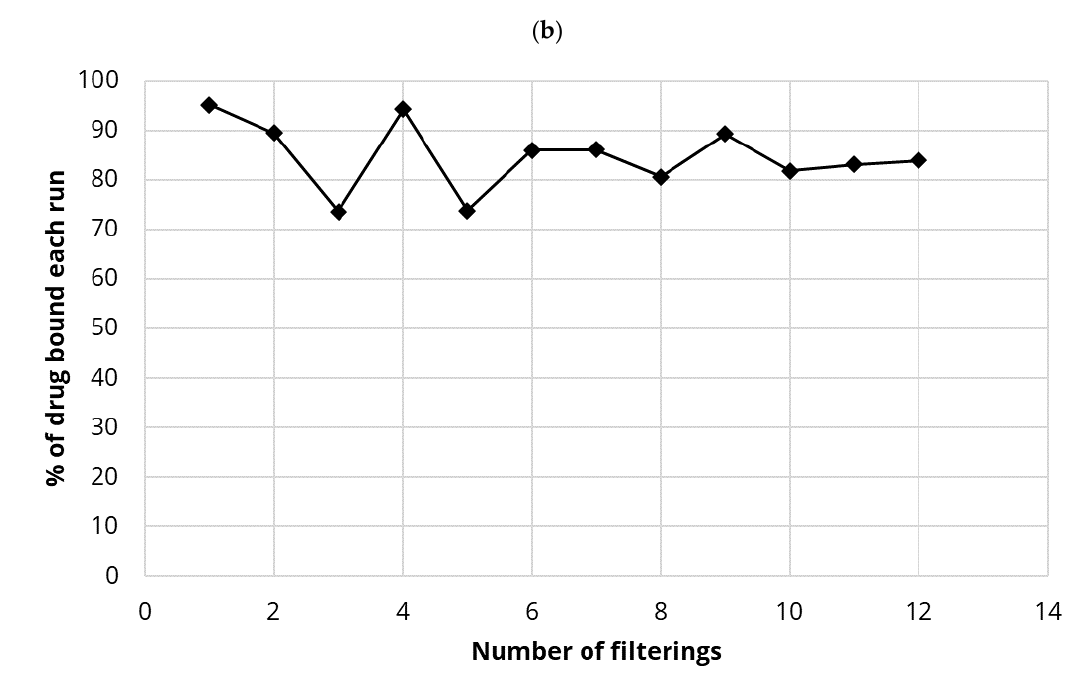
Figure 8. ( a ). Binding percentage of diclofenac (repeated volumes of 5 mL of 2 µg/mL) for polydiallyl dimethyl ammonium chloride-CNC (PDMC-CNC) (5 mg integrated small-scale filter. ( b ). Binding percentage of diclofenac (repeated volumes of 5 mL of 2 µg/mL) for PDMC-CNC (20 mg) integrated small-scale filter.